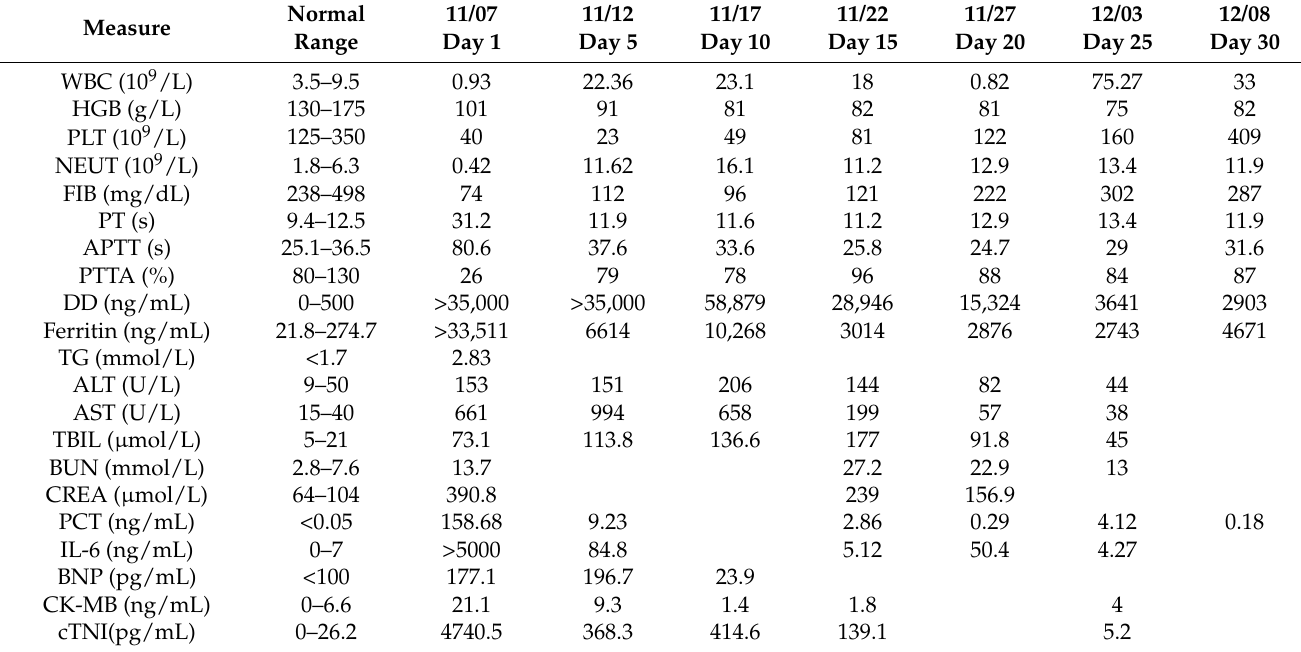
Figure 1. High-resolution computed tomography images during the disease course. ( A ) Upper panel: diffuse infection of both lungs with multiple patchy, nodular shadows, interstitial pulmonary oedema, and a small amount of pleural effusion bilaterally. ( B ) Low panel: enlarged liver and spleen size, brain cell oedema. Table 1. Clinical laboratory